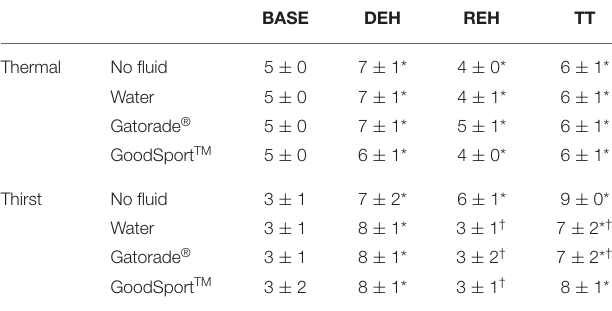
TABLE 6 | Thermal and thirst sensation